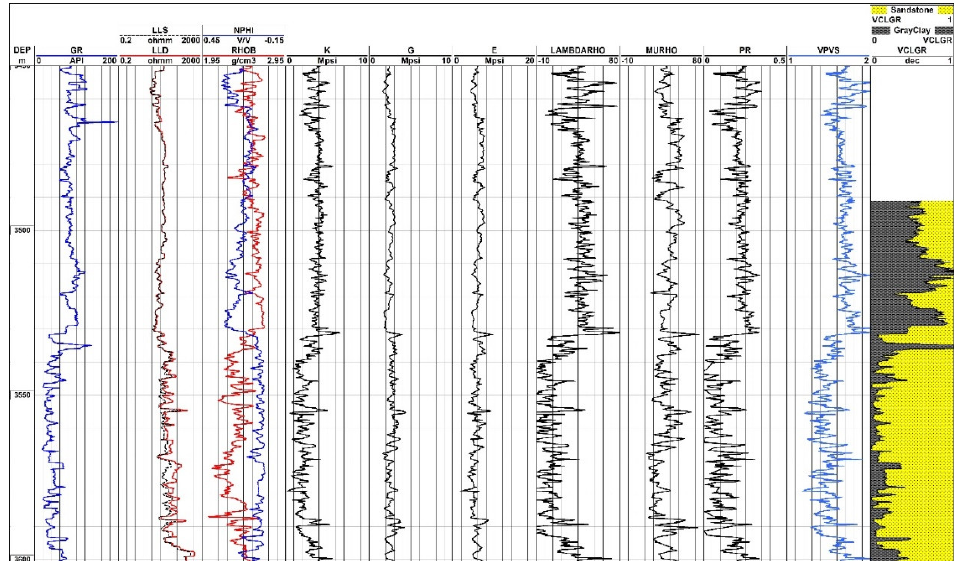
Figure 16. Standard petrophysical logs (tracks-2–4), mechanical properties (tracks-5–9), and elas- tic/seismic logs (tracks-10–11) provide a reliable and consistent interpretation of lithology (track-12) of Rehmat-02.